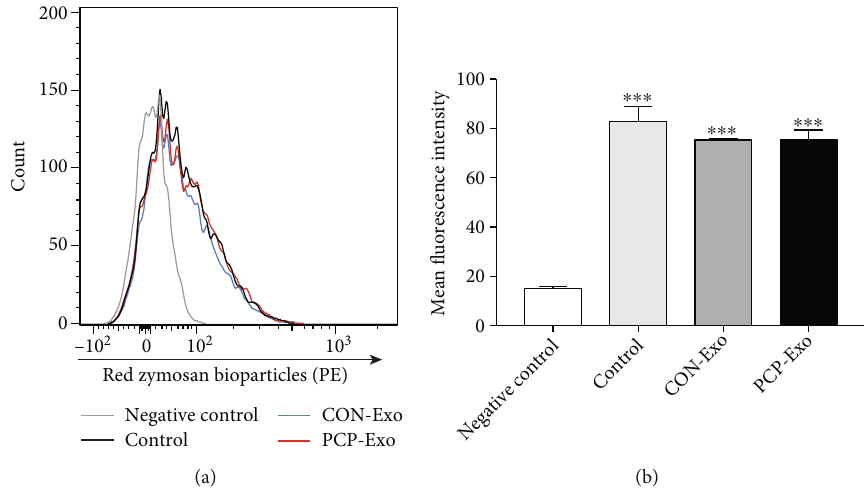
Figure 7: E ff ect of B cell-derived exosomes on phagocytic capacity of alveolar macrophages. AMs were isolated from fi ve uninfected mice and treated with CON and PCP B cell exosomes or left untreated (control). AMs from di ff erent groups were incubated with dye-labeled zymosan particles to examine the phagocytic function. For negative control, only AMs were added. (a) Representative fl ow cytometric histogram showing the particle fl uorescence within macrophages from di ff erent groups. (b) Comparison result of mean fl uorescence intensity of four groups ( n = 3 ). Comparison was conducted by one-way ANOVA, followed by Bonferroni post hoc test. ∗∗∗ p < 0 : 001 compared with the negative control. AMs: alveolar